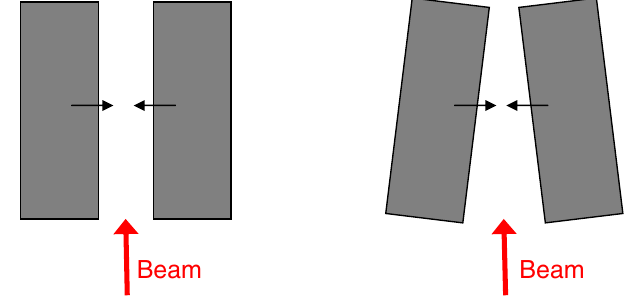
FIG. 9. (Color) Schematic sketch of collimator jaws kept paral- lel to the beam direction when moved in (left) and with a 2 mrad angle